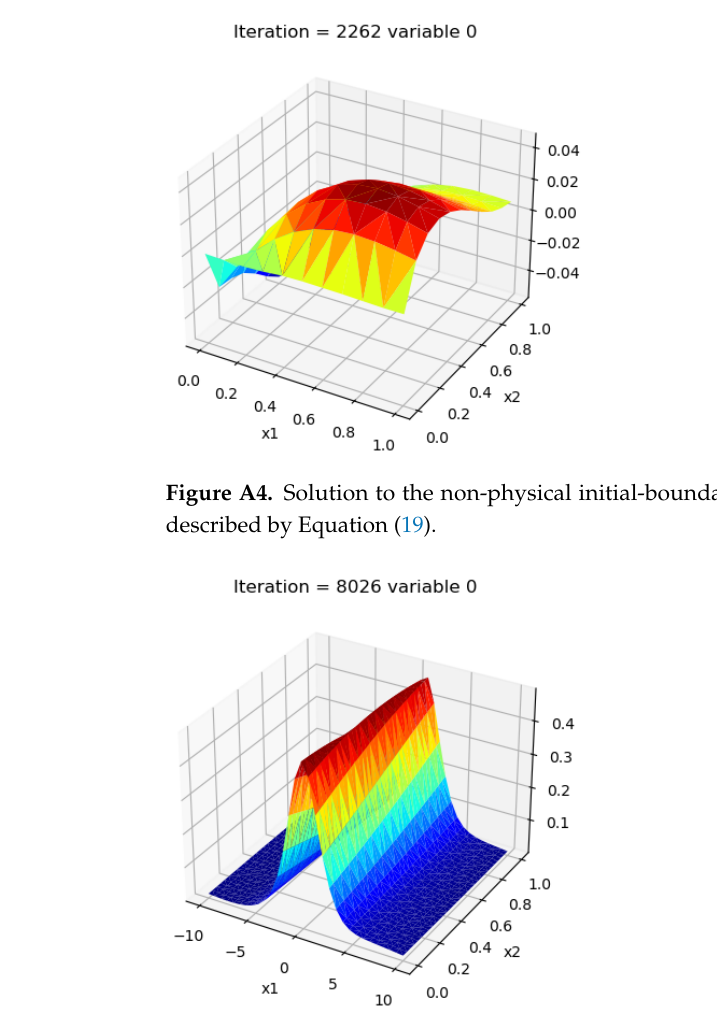
Figure A5. Solution to the non-physical initial-boundary value problem of the KdV equation, as described by Equation